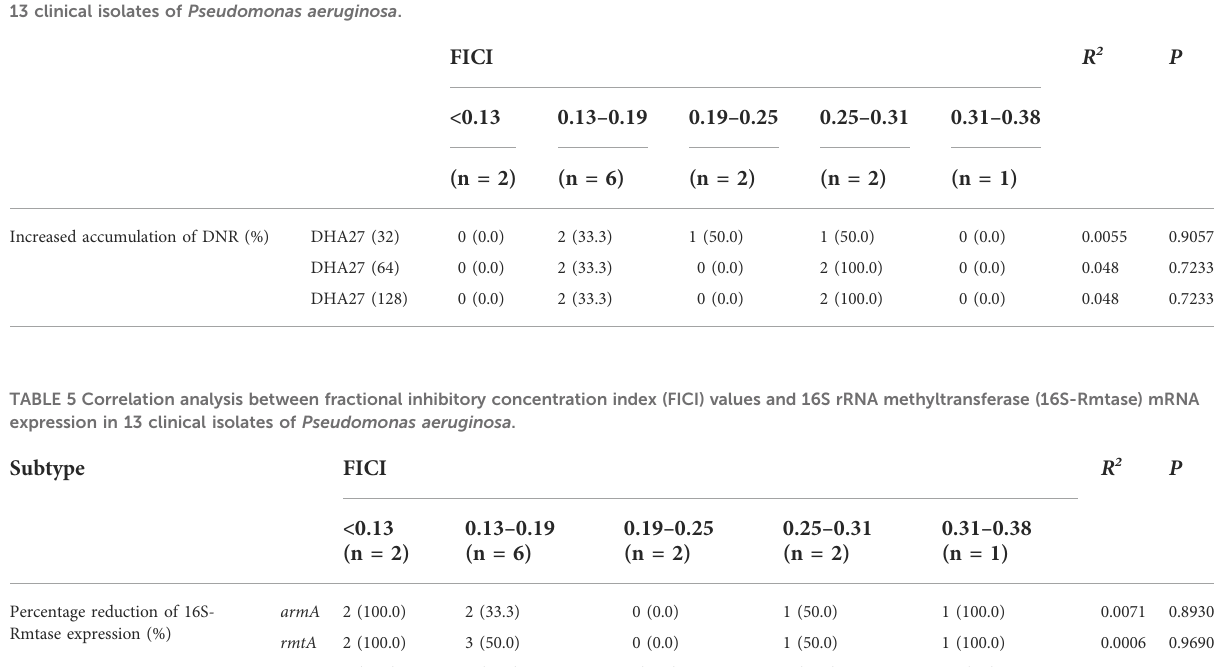
TABLE 4 Correlation analysis between fractional inhibitory concentration index (FICI) values and enhanced daunorubicin (DNR) accumulation in 13 clinical isolates of Pseudomonas aeruginosa .